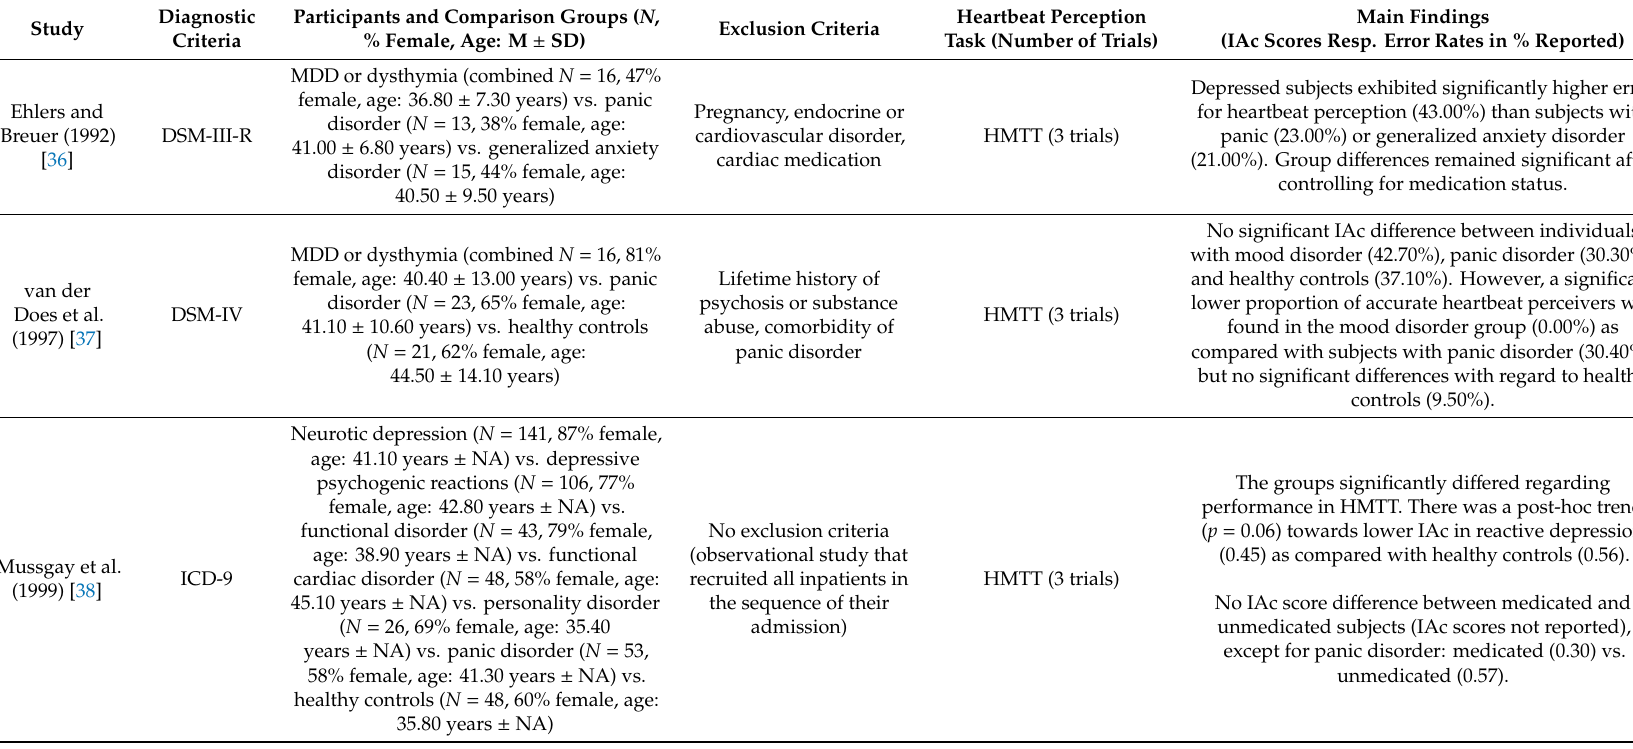
Table 1. Characteristics of included